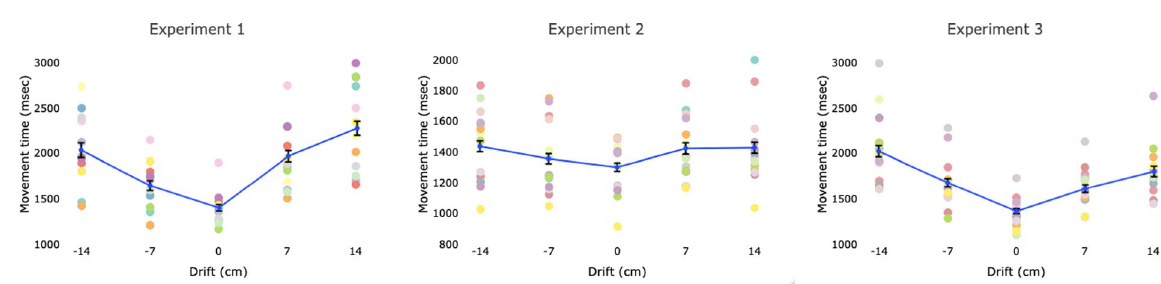
Figure 3. Average movement times across hand drifting conditions in the three experiments. The error bars indicate standard errors of the mean. Participants’ performance across displacement conditions is represented with circular markers of different